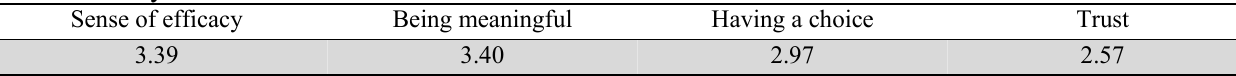
The summary of Freedman test Sense of efficacy Being